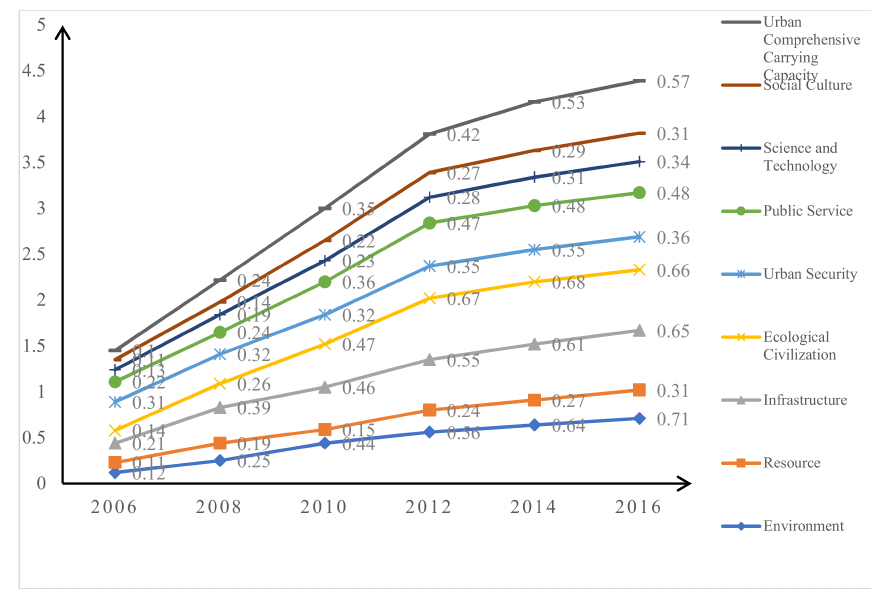
Figure 3. The results of the urban comprehensive carrying capacity of Harbin city.